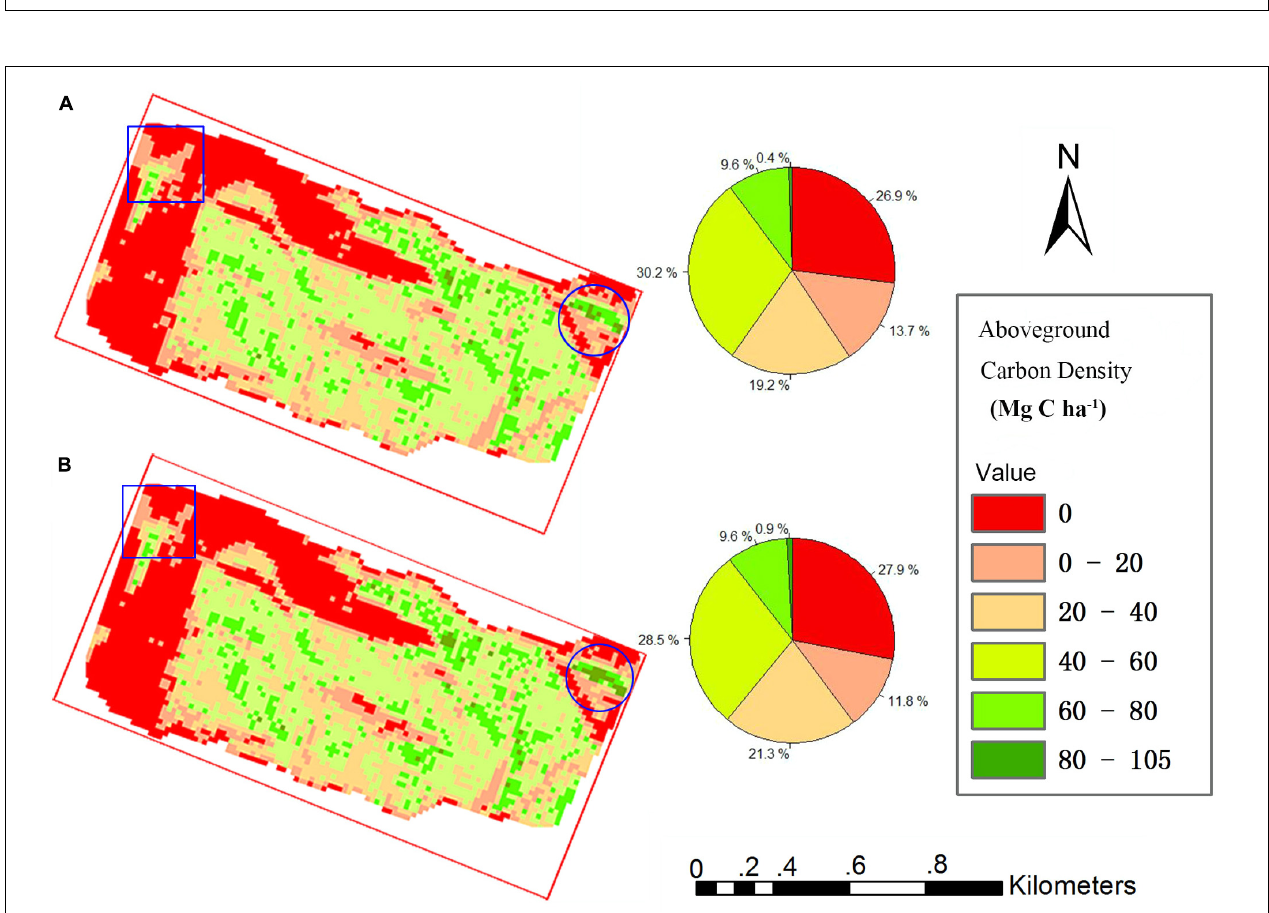
FIGURE 6 | Study area carbon density map predicted using the TCH model (A) and percentile model (B) . Square is low density area, Round is high density area.